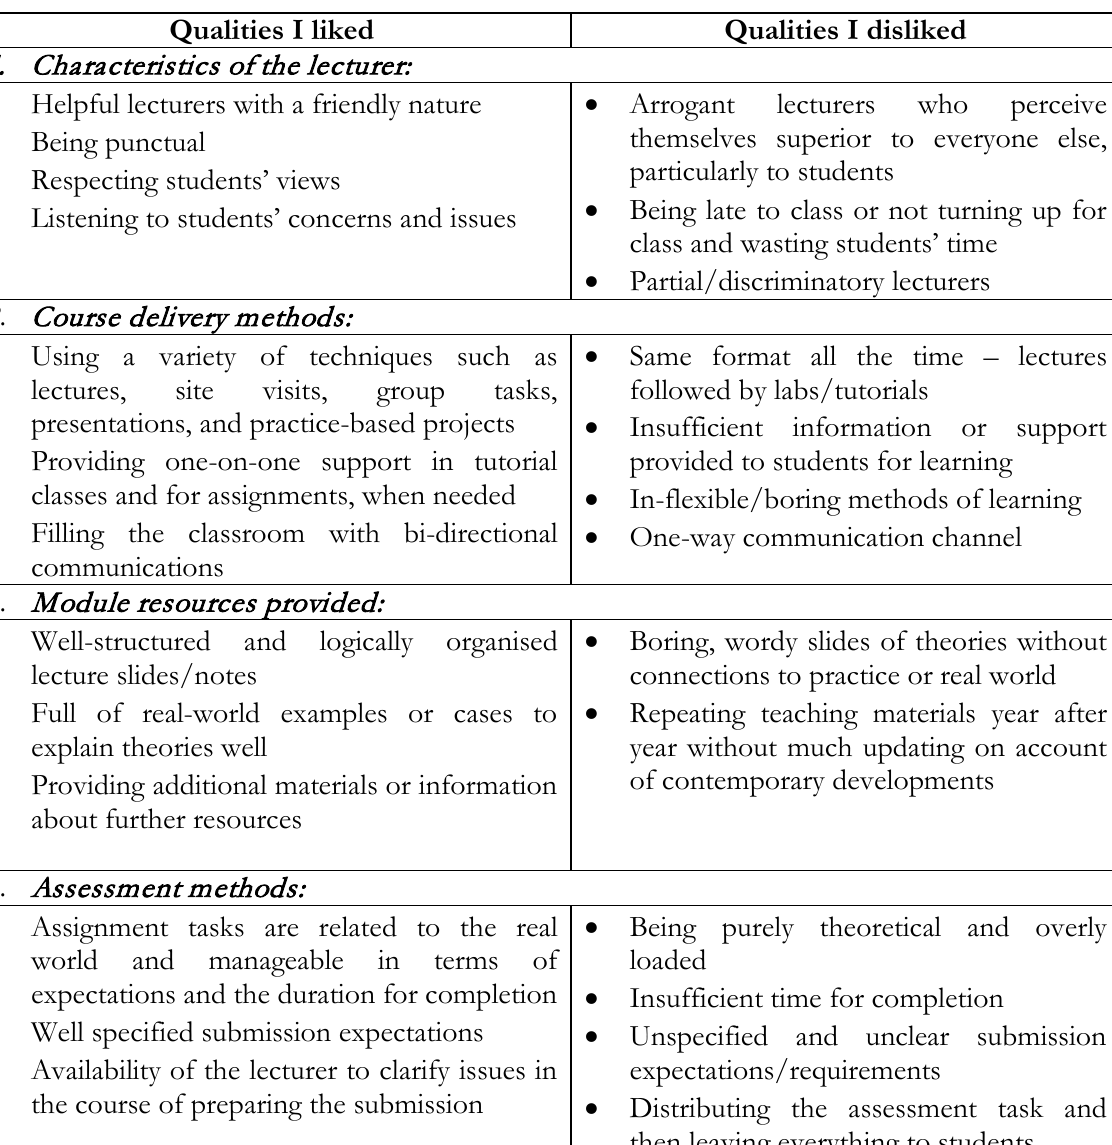
Table 1: Self-reflection as a